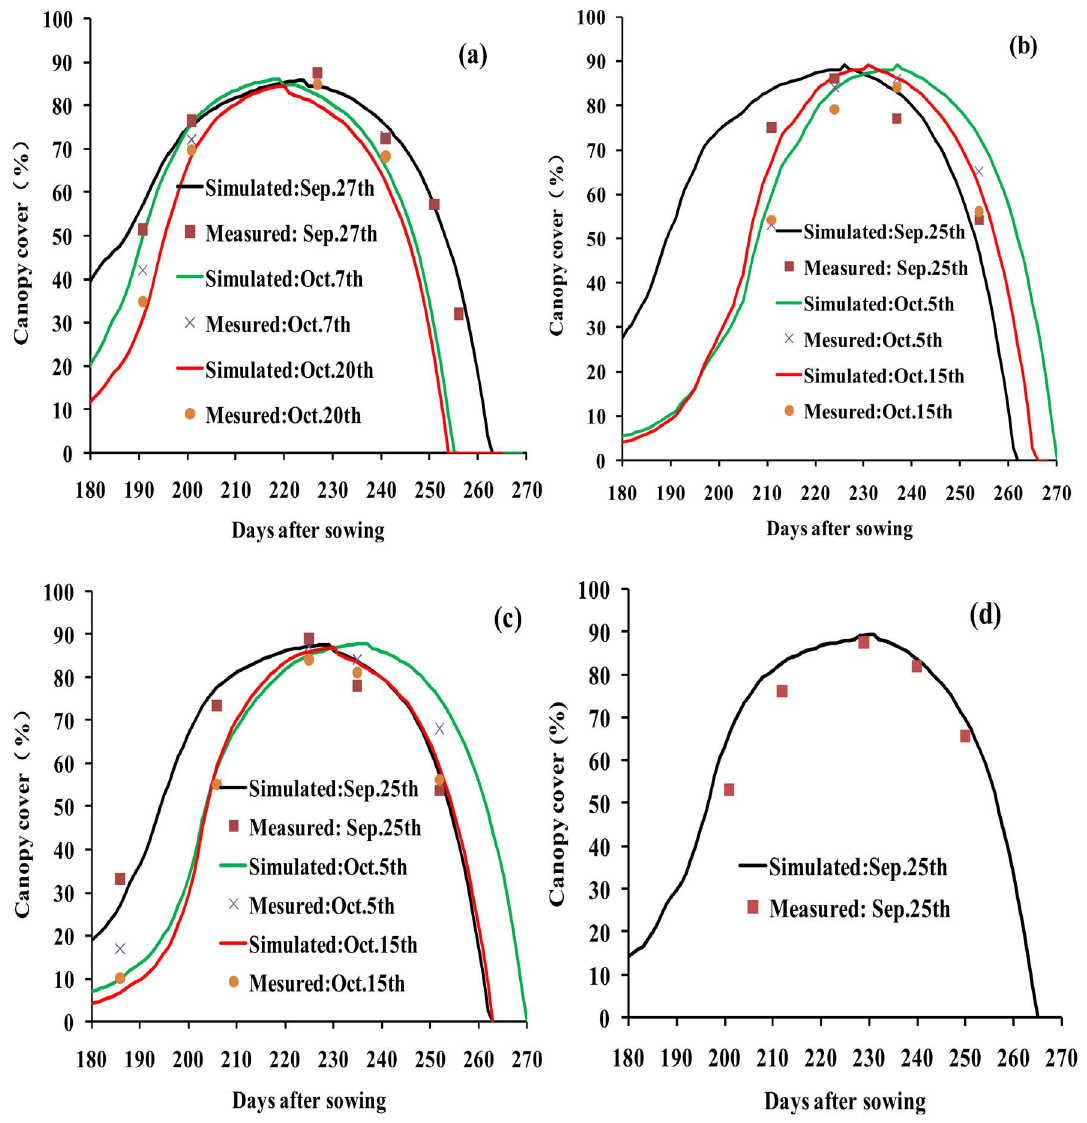
Figure 2. Simulated and measured canopy cover (CC) for winter wheat under different planting dates and irrigation strategies in the cropping season 2008/2009 (a), 2009/2010 (b), 2010/2011 (c) and 2011/2012